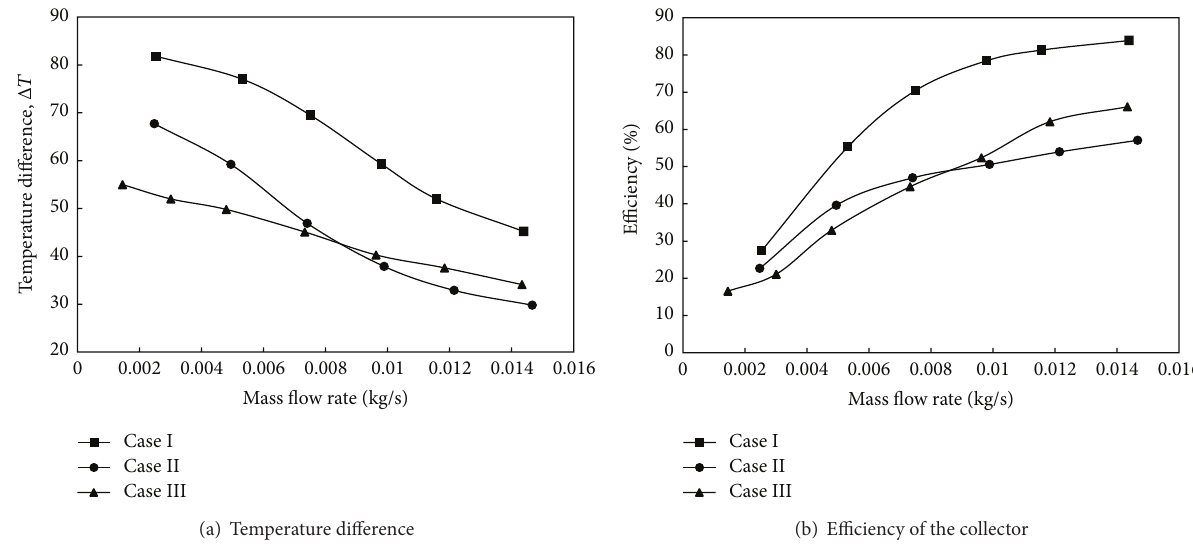
Figure15:Temperaturedifferenceandefficiencyofthecollectorversusmassflowrateforvariousabsorberplatesbyexperimentmeasurement.